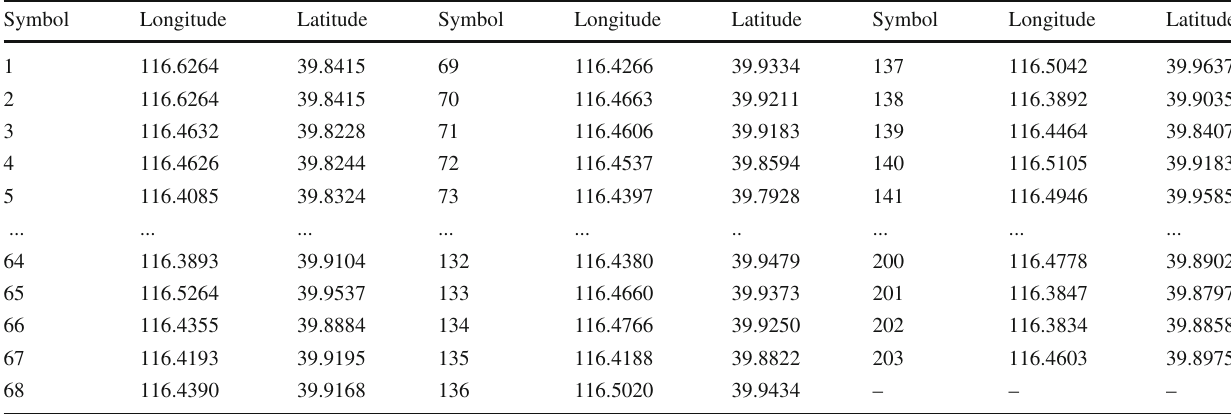
Table 1 Customer’s longitude position